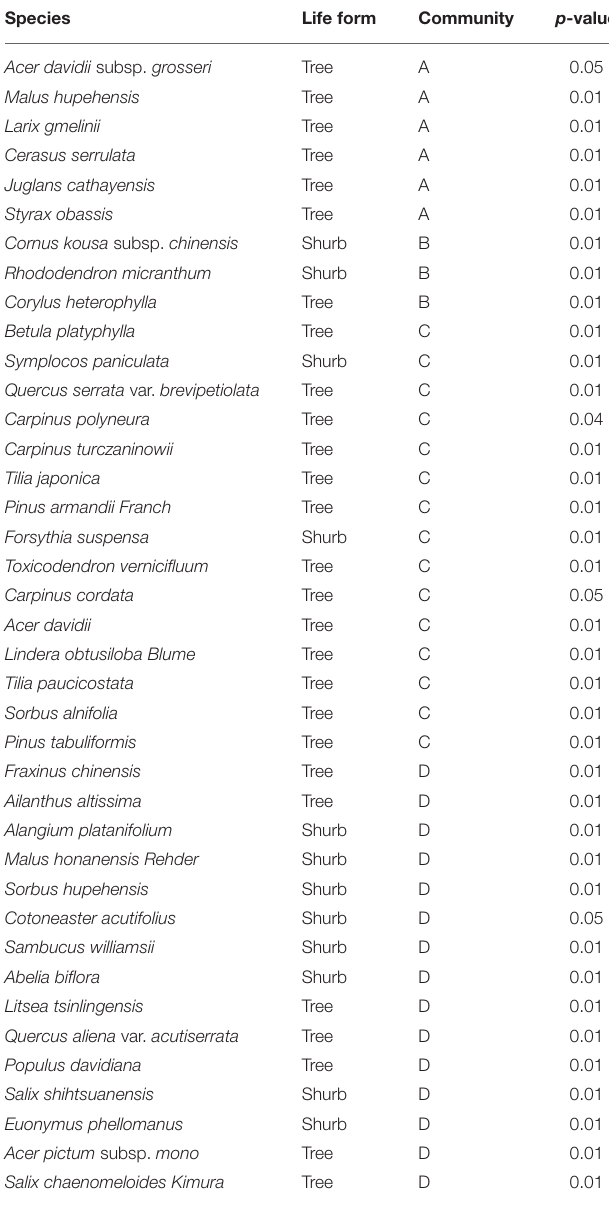
TABLE 2 | Indicator species analysis in the four communities ( p ≤ 0.05 level of